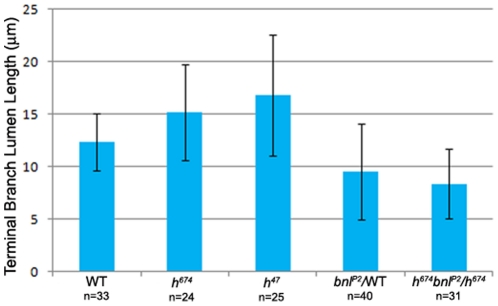
Hairy and Bnl control terminal cell lumen length.Graph showing lumen length of terminal branches in wild-type embryos, h674 and h47 homozygous embryos, bnlP2 heterozygous embryos and h674homozygous embryos with one copy of bnlP2. n =  number of terminal branches scored. Values are means ± S.D. P<0.001.